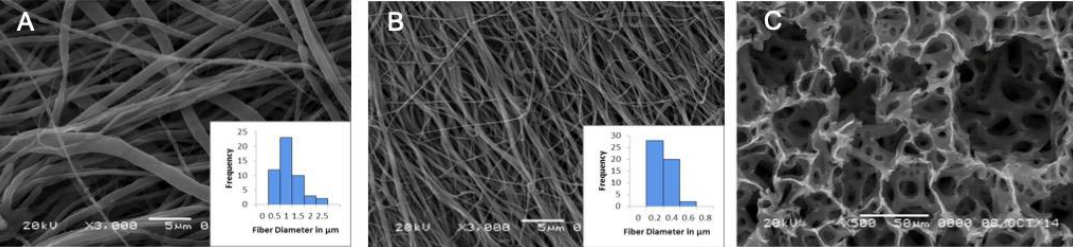
Figure 1. PCL scaffolds electrospun from ( A ) HFP and (B)a binary solvent system of formic acid and acetic acid (1:3). PCL fibers from HFP show a bimodal distribution with mean diameter of 1.37 µm. PCL electrospun from FAA show a narrow fibers (mean diameter of 0.21 µm) but much more uniform fiber size distribution. Panel ( C ) is the image of macroporous Alvetex scaffolds demonstrating interconnected pore structure.